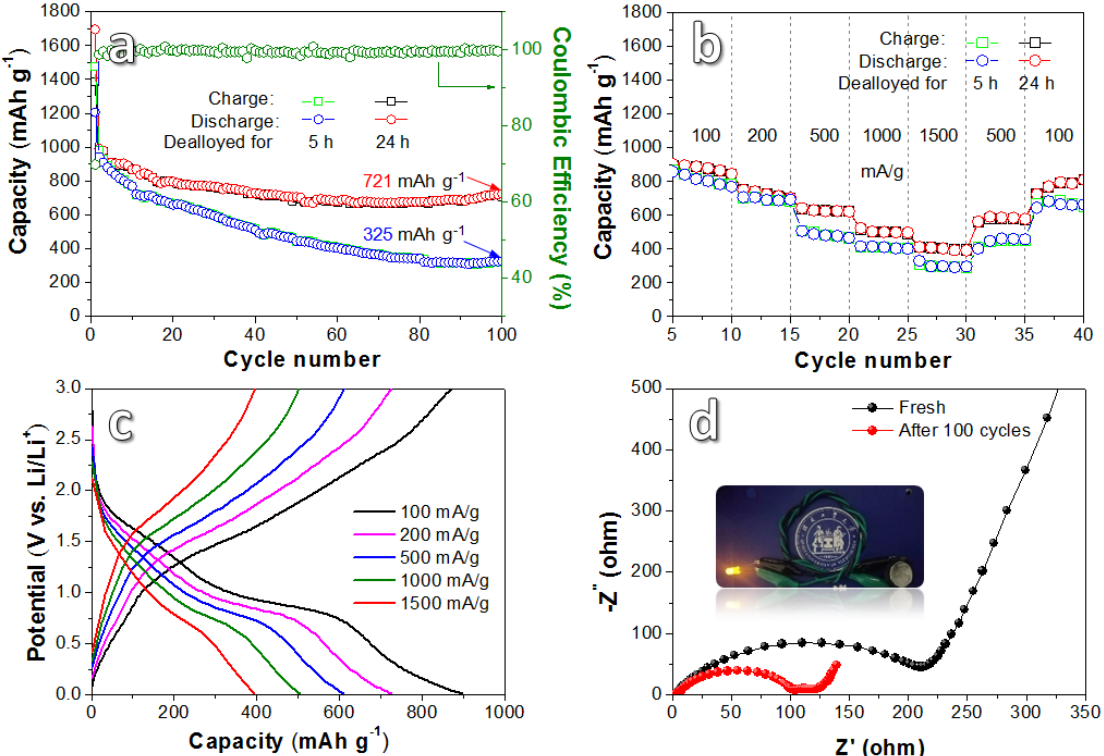
( a ) Cycling performance of the electrode materials testing at a current density of 100 mA g − 1 for 100 cycles; ( b ) rate performances of the products tested at di ff erent current densities; ( c ) galvanostatic charge / discharge curves of the products dealloyed for 24 h at di ff erent current densities; ( d ) electrochemical impedance spectroscopy (EIS) interceptions of the products dealloyed for 24